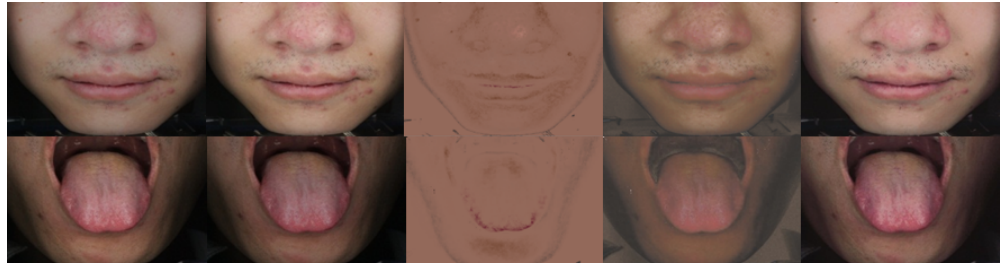
Figure 9. Subjective results of the 4 compared methods. From left to right, they are uncorrected and the results of the POLY, SVR, K-PLSR, and Ours. Table 8. Comparison results of color differences using four methods under different illuminances.